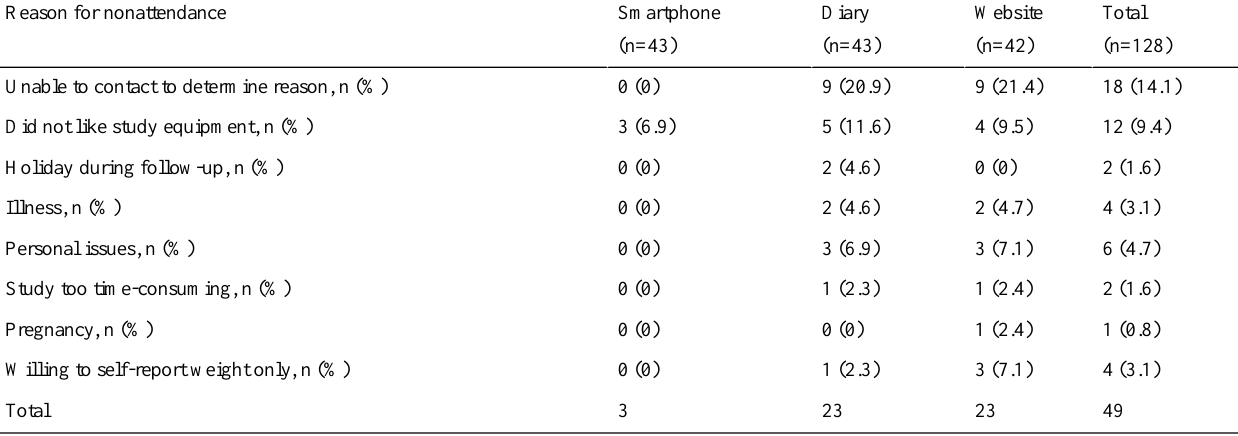
Table 3. Reasons for nonattendance at 6-month follow-up for trial